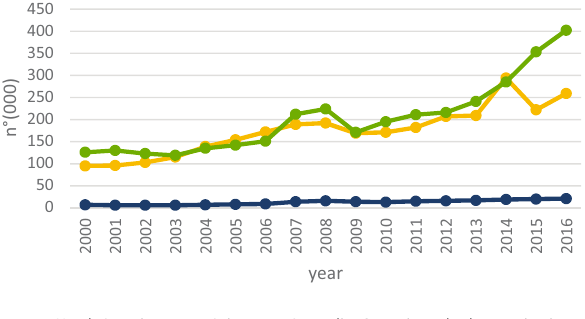
Figure 2: Total tourist arrivals in Romania from non - European countries for the period 2000 – 2016 ( source: author ’ s own elaboration on data available at http://statistici.insse.ro:8077/ tempo - online/#/pages/tables/insse - table ) .